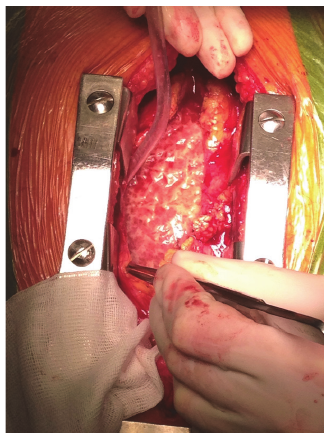
Figure 3: Bread and butter appearance upon opening the peri- cardium. The “bread and butter” appearance seen upon separating the visceral and parietal surfaces of the pericardium during surgery is typical for fibrinous